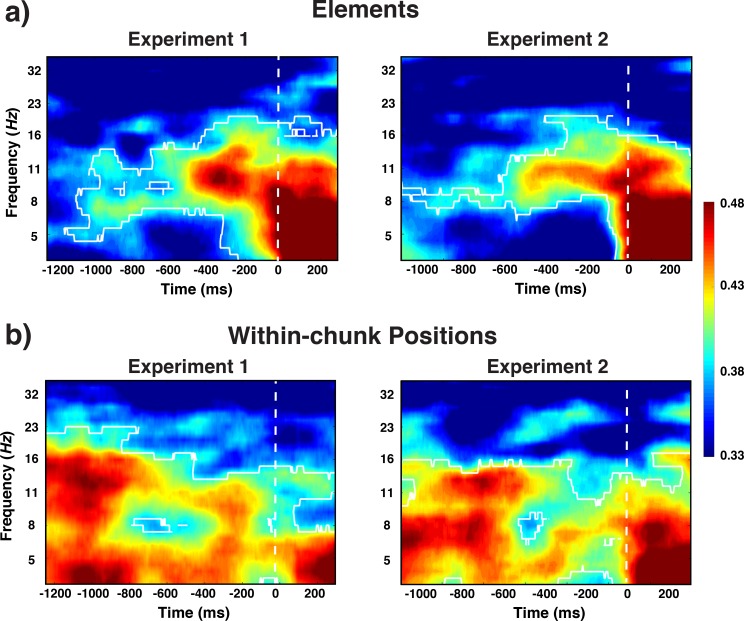
Experiment 1 and 2 decoding results as a function of frequency and time relative to probe-stimulus onset for elements/orientations.(a) and within-chunk positions (b). The legend shows the decoding accuracy in probability. Chance level is p = 0.33. The regions enclosed by white lines show significant decoding accuracy after cluster correction.